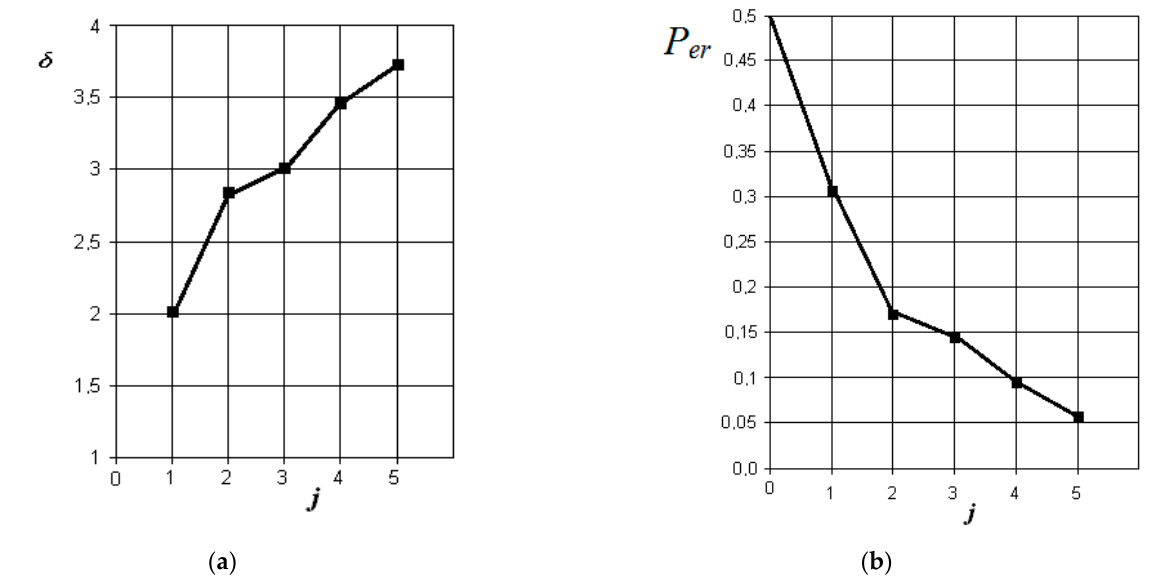
Figure 7. The results of discriminant data analysis when comparing the norm with acute purulent odontogenic sinusitis: ( a ) the dependence of the increase in the normalized Euclidean distance as signs are added to the discrimination model δ = f ( j ) ; ( b ) the dependence of the decrease in the probability of a decision error as signs are added to the discrimination P = f ( j ) : j = 5-is the dimension of the space of informative parameters.